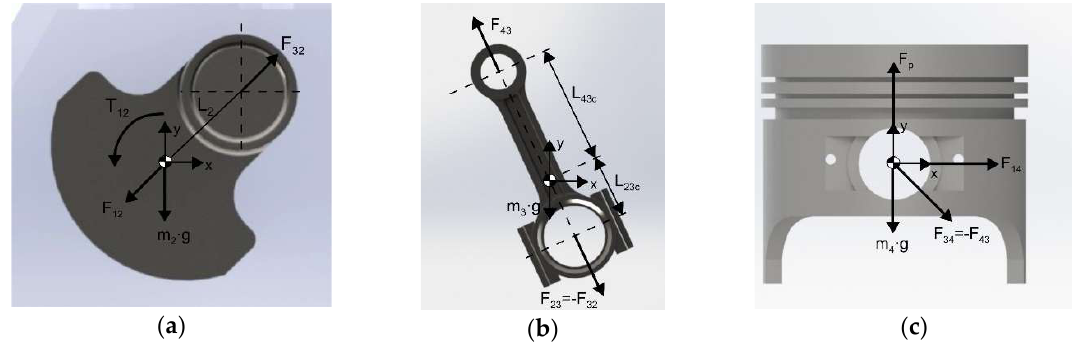
4 of 20 Figure 2. Scheme kinematic model for decentered sliding rod-crank-mechanism. (cid:3428)𝐿 (cid:2871) ∙ 𝑠𝑒𝑛(𝛽) 1 𝐿 (cid:2871) ∙ 𝑐𝑜𝑠(𝛽)